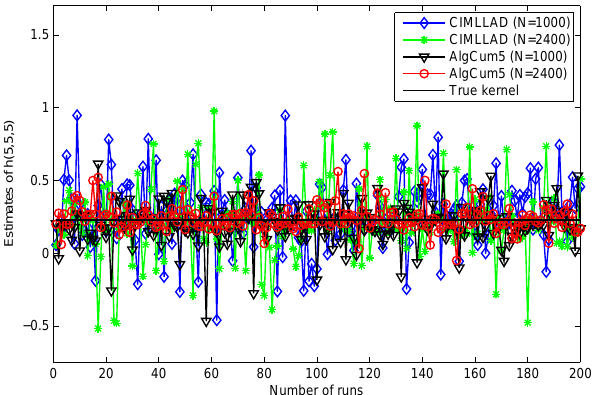
Figure 13. Estimated cubic kernel, h ( 5,5,5 ) = 0.227, for system II. Figure 14, where we present the NMSE as function the SNR, gives us a good idea about the precision of the estimated kernels. For high noise level (SNR = 0 dB), the NMSE using the proposed approach is almost 9 times lower than for the CIM-LLAD. The reason is the same as in system I: the proposed approach uses only the fifth-order cumulants, which are able to remove most of the Gaussian noise, allowing a more accurate identification of the cubic